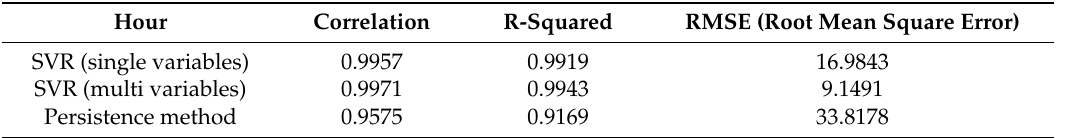
Table 3. Accuracy of SVR model and Persistence method (8 January 2016).